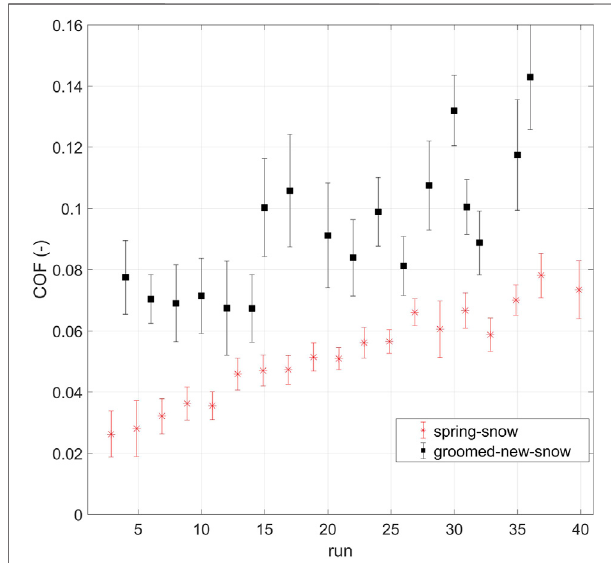
FIGURE 4 | COFs (mean ± σ ) of consecutive snowboard runs throughout a test day (ca. 9:00 – 15:00) on spring snow (18/04/08), and on groomed newsnow(18/03/28)withincreasingLWCfrom0%toca.10%.The consecutive numbering of the runs also includes runs performed by skiers which are not